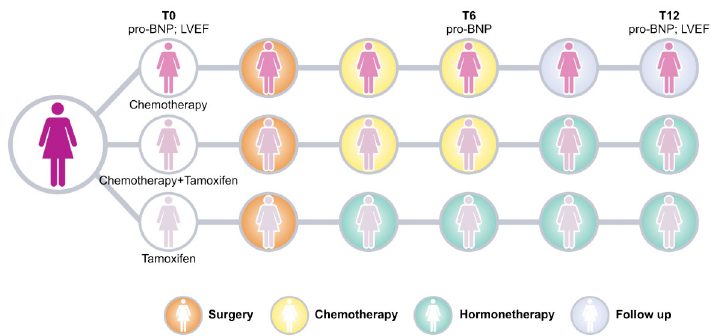
Figure 1. Group division: women who received chemotherapy treatment for 6 months;